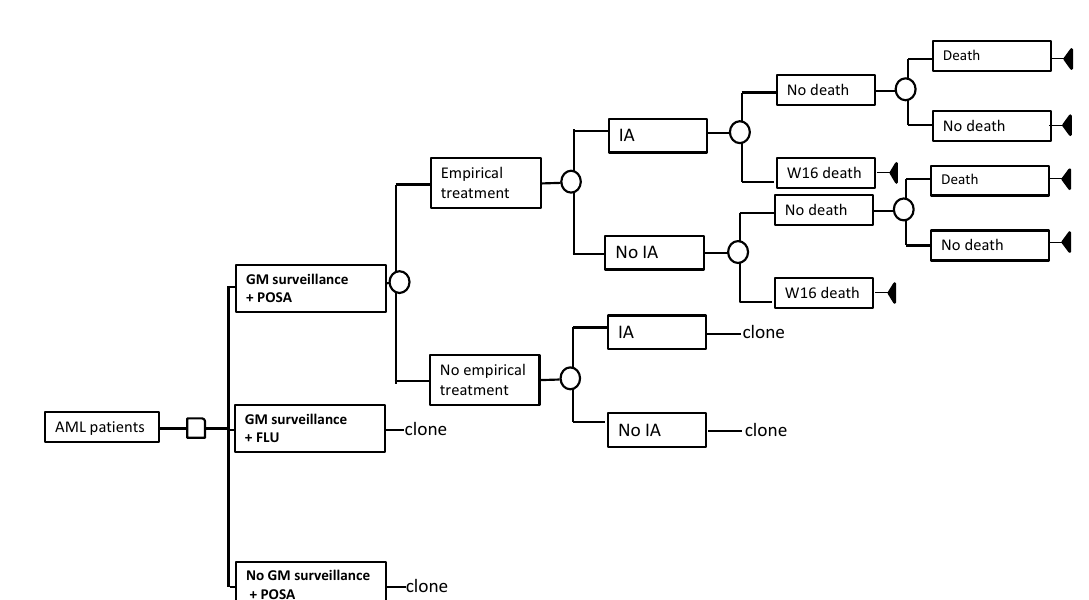
Figure 1. Schematic representation of the decision–analytic model. The model simulated patients with myelosuppression who underwent either twice-weekly routine galactomannan surveillance while receiving antifungal prophylaxis (non- mould-active prophylaxis, i.e., fluconazole, or mould-active prophylaxis, i.e., posaconazole). Patients surviving the IA and the initial 16 weeks (W16) proceeded on to a yearly Markov cycle until death occurred. AML: acute myeloid leukaemia, FLU: fluconazole, GM: galactomannan, IA: invasive aspergillosis, POSA: posaconazole.